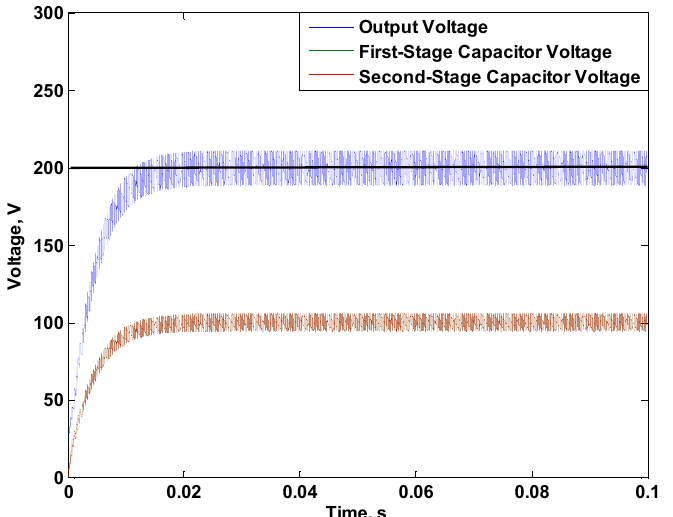
Figure 16. First-stage and second-stage inductor currents at a reference voltage of 100 V.